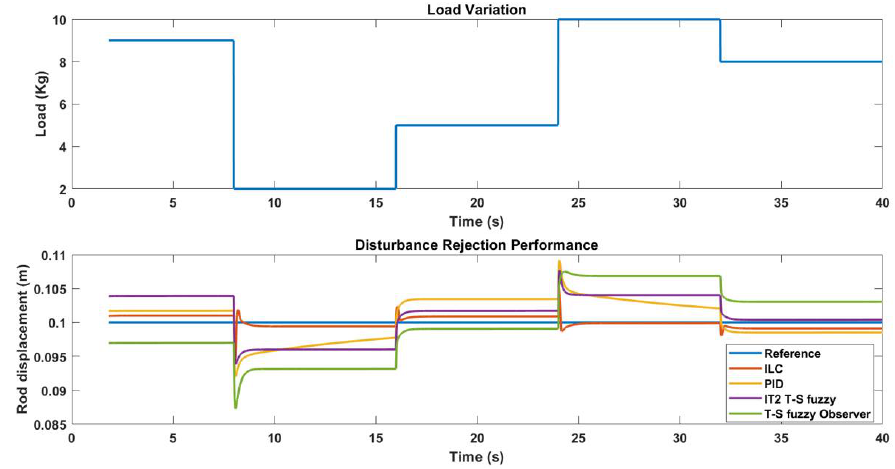
Table 3. Comparison between the controllers’ performance in disturbance rejection.